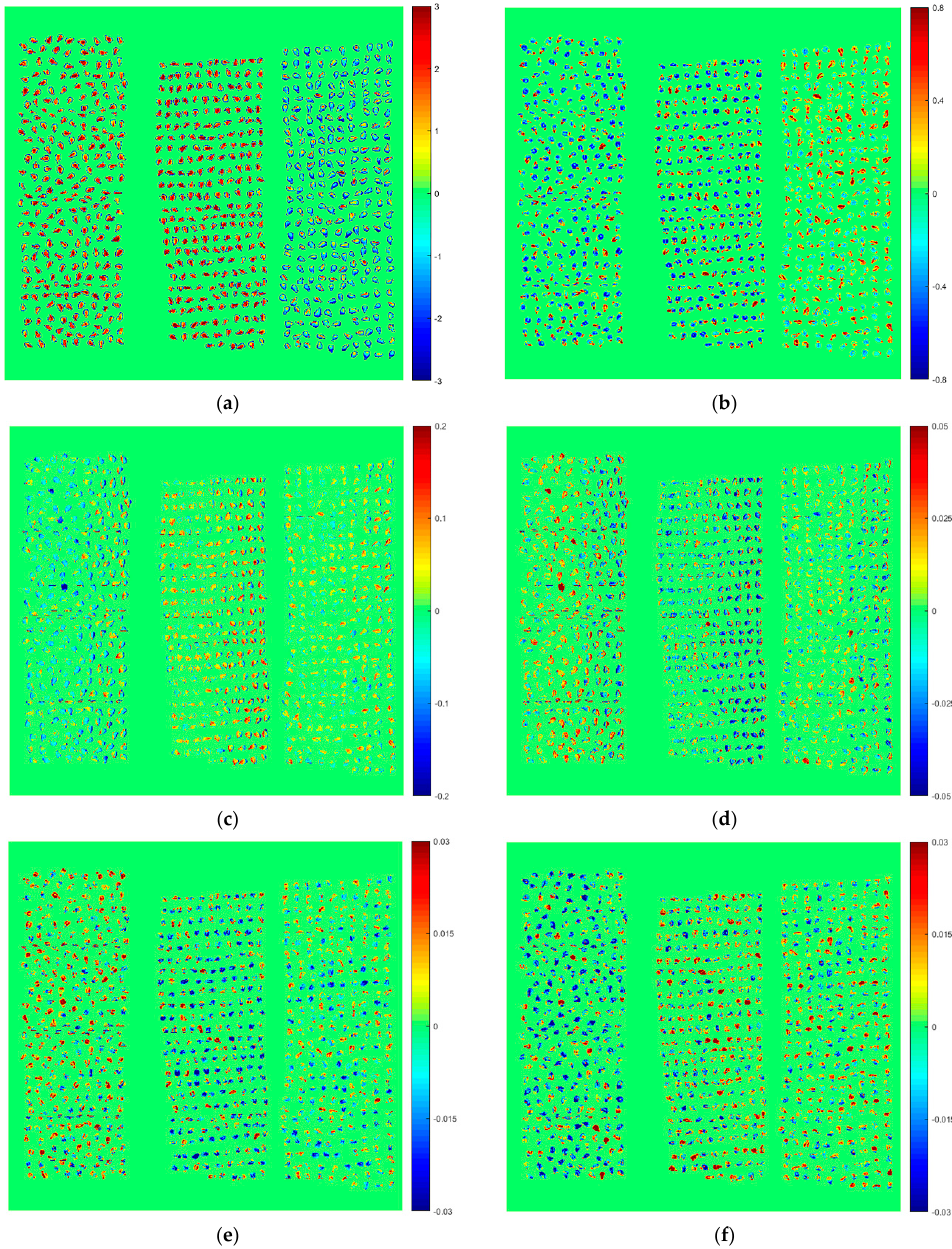
Figure 2. Scores images of the first six principal components (PCs) for: ( a ) PC1; ( b ) PC2; ( c ) PC3; ( d ) PC4; ( e ) PC5; and ( f ) PC6.